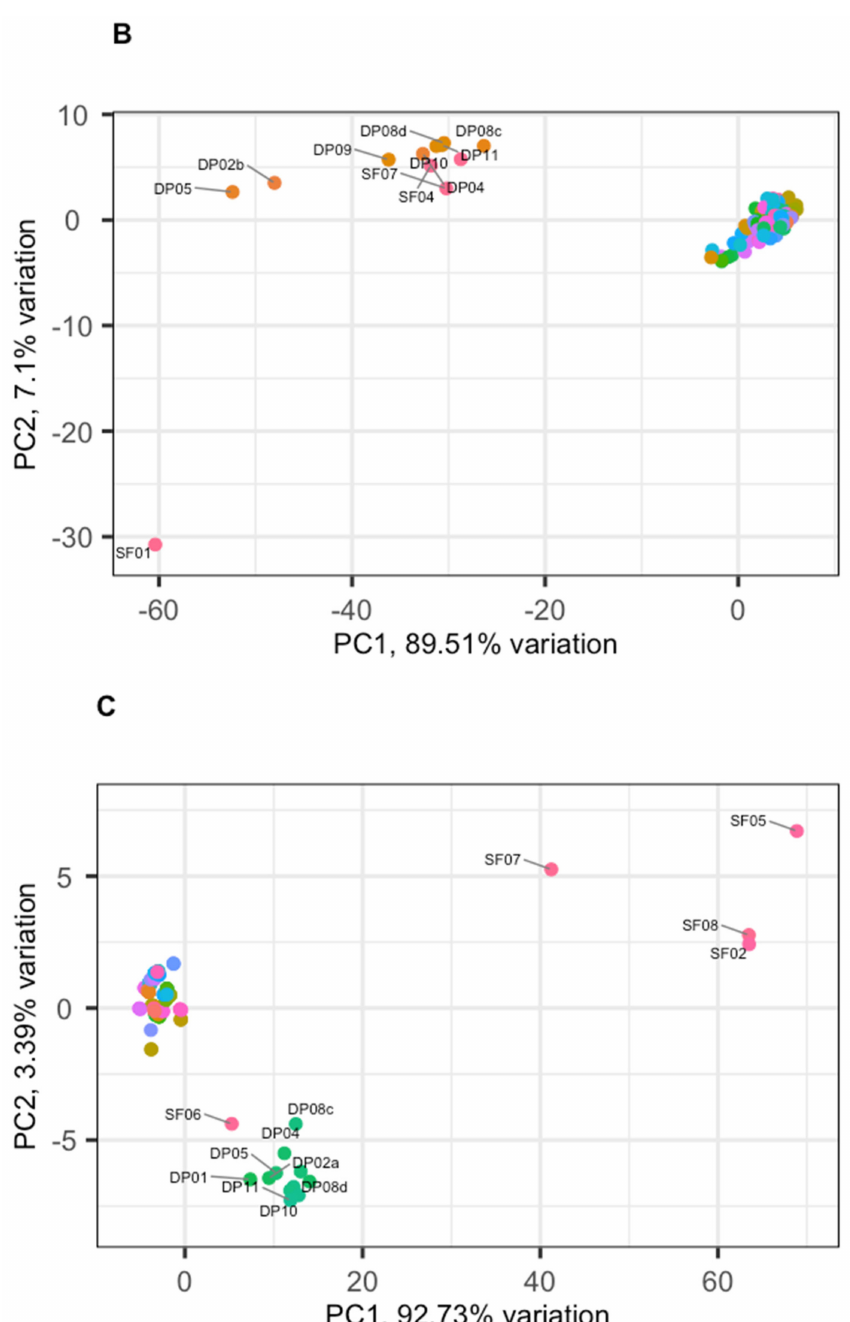
Figure 5. Principal component analysis biplots for sample composition-independent diversity comparison based on sequence distance measures as obtained for Lactococcus phage: c2 ( A ), 936 ( B ), and P335 ( C ) types. Labeled points represent phage sequences amplified on metagenomic DNA from dairy plants (DP-) or spontaneous fermentation (SF- produced curd cheeses; unlabeled points represent sequences derived from BLAST search